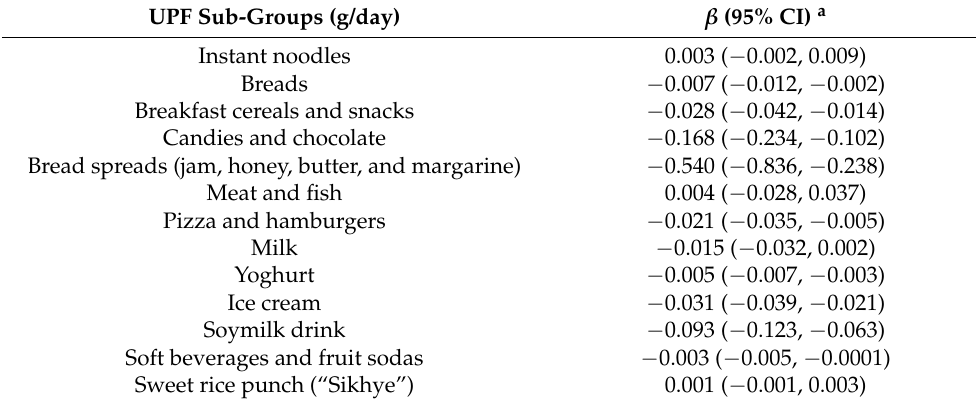
Table 5. Regression coefficients for the association between UPF sub-groups and eGFR. UPF Sub-Groups (g/day) β (95% CI) a Instant noodles 0.003 ( − 0.002, 0.009) Breads − 0.007 ( − 0.012, − 0.002) Breakfast cereals and snacks − 0.028 ( − 0.042, − 0.014) Candies and chocolate − 0.168 ( − 0.234, − 0.102) Bread spreads (jam, honey, butter, and margarine) − 0.540 ( − 0.836, − 0.238) Meat and fish 0.004 ( − 0.028, 0.037) Pizza and hamburgers − 0.021 ( − 0.035, − 0.005) Milk − 0.015 ( − 0.032, 0.002) Yoghurt Soymilk drink Soft beverages and fruit sodas − 0.003 ( − 0.005, − 0.0001) Sweet rice punch